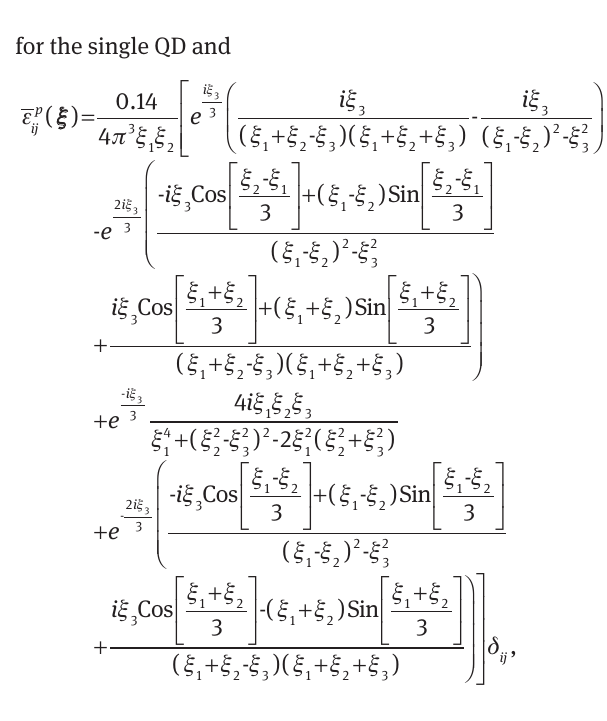
, i = 1, 3, and electric i , along the x 3 1